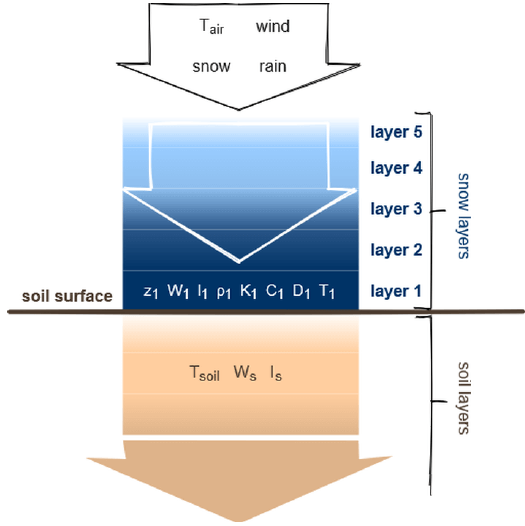
Figure 1. Snowpack structure and physical properties. Where z shows layer depth, W water content, I ice content, ρ density, C heat capacity, K thermal conductivity, D thermal diffusivity, and T layer temperature. A detailed list of the used variables can be found in Table